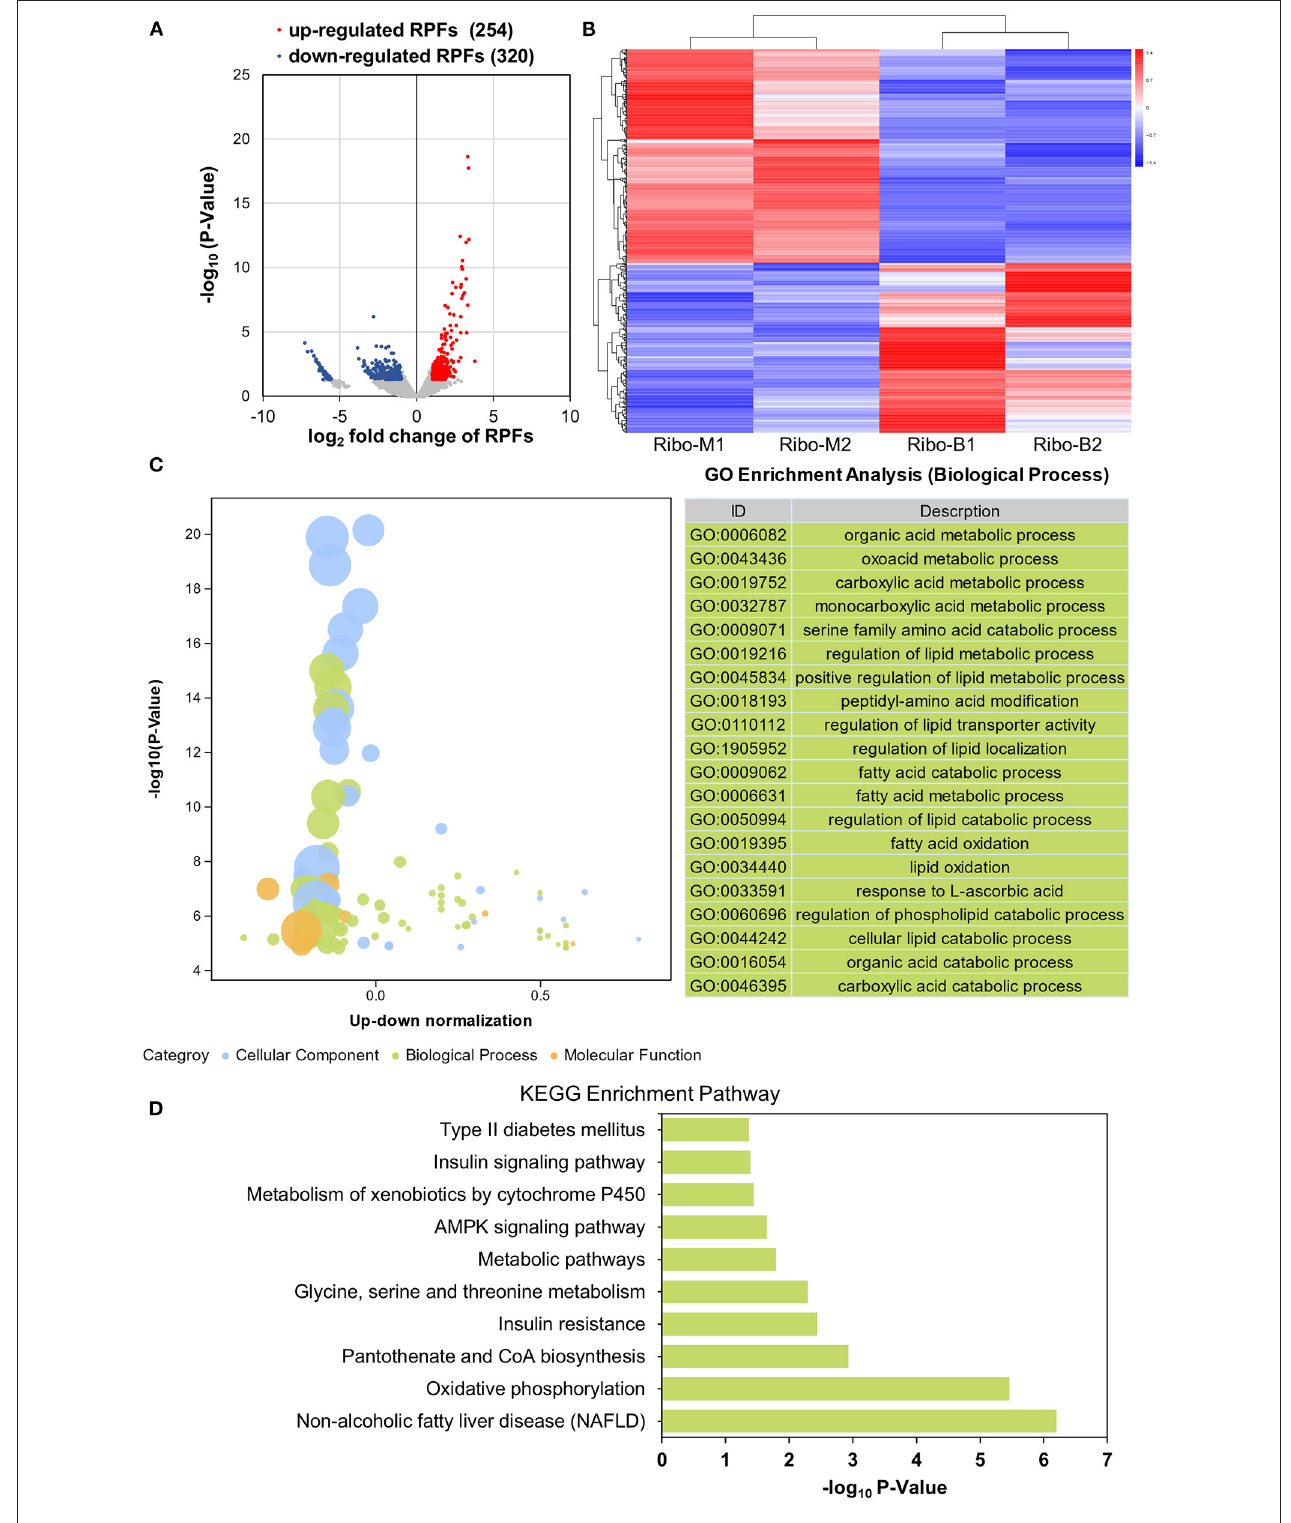
FIGURE 4 | Translatome analysis. (A) Volcano plots of liver DEGs of the translatome. (B) Heatmap demonstrating the abundance of DEGs. (C) An advanced bubble diagram showing GO annotation classification analysis of the DEGs. (D) KEGG analysis of DEGs in the translatome.